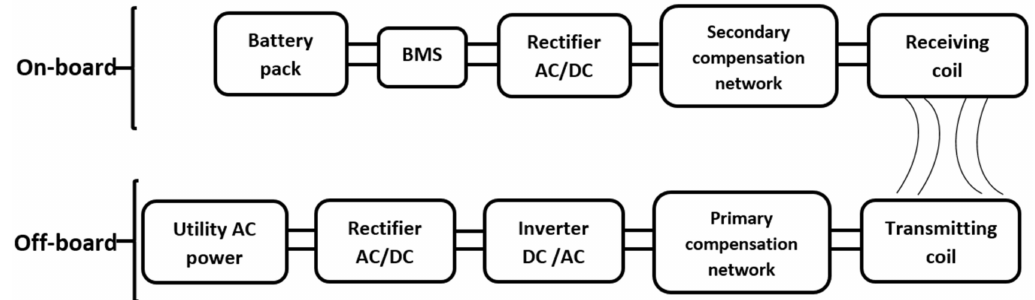
Figure 2. Unidirectional magnetic resonance wireless power transfer for electric vehicle